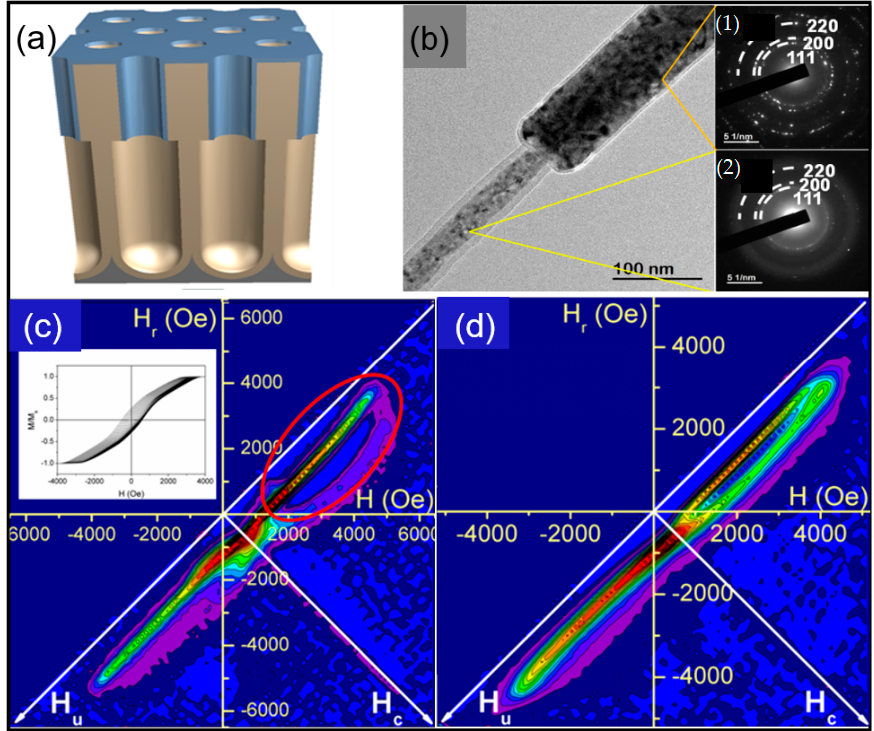
Figure 9. ( a ) Schematic view of highly ordered alumina template with modulated pores, ( b ) HRTEM image of a bi-segmented Ni nanowire. The insets show the Selected Area Electron Diffraction (SAED) patterns corresponding to the wide and narrow segments of the nanowire shown in ( b , c ) First-Order Reversal Curve (FORC) distribution diagram for the bi-segmented Ni nanowire arrays. The inset shows the hysteresis curves used for calculating the respective FORC diagram ( d ). FORC distribution diagram for the Ni nanowire arrays with 80 nm in diameter (Adapted with permission from ref. [57]. Copyright 2019 Springer Nature.).